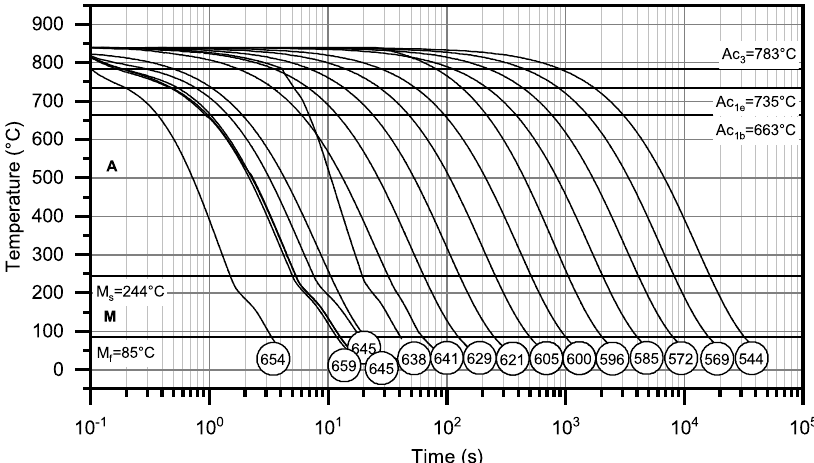
Figure 4. Experimentally determined CCT-diagram for an austenitization time of 300 s at 840 °C (hardness HV30).